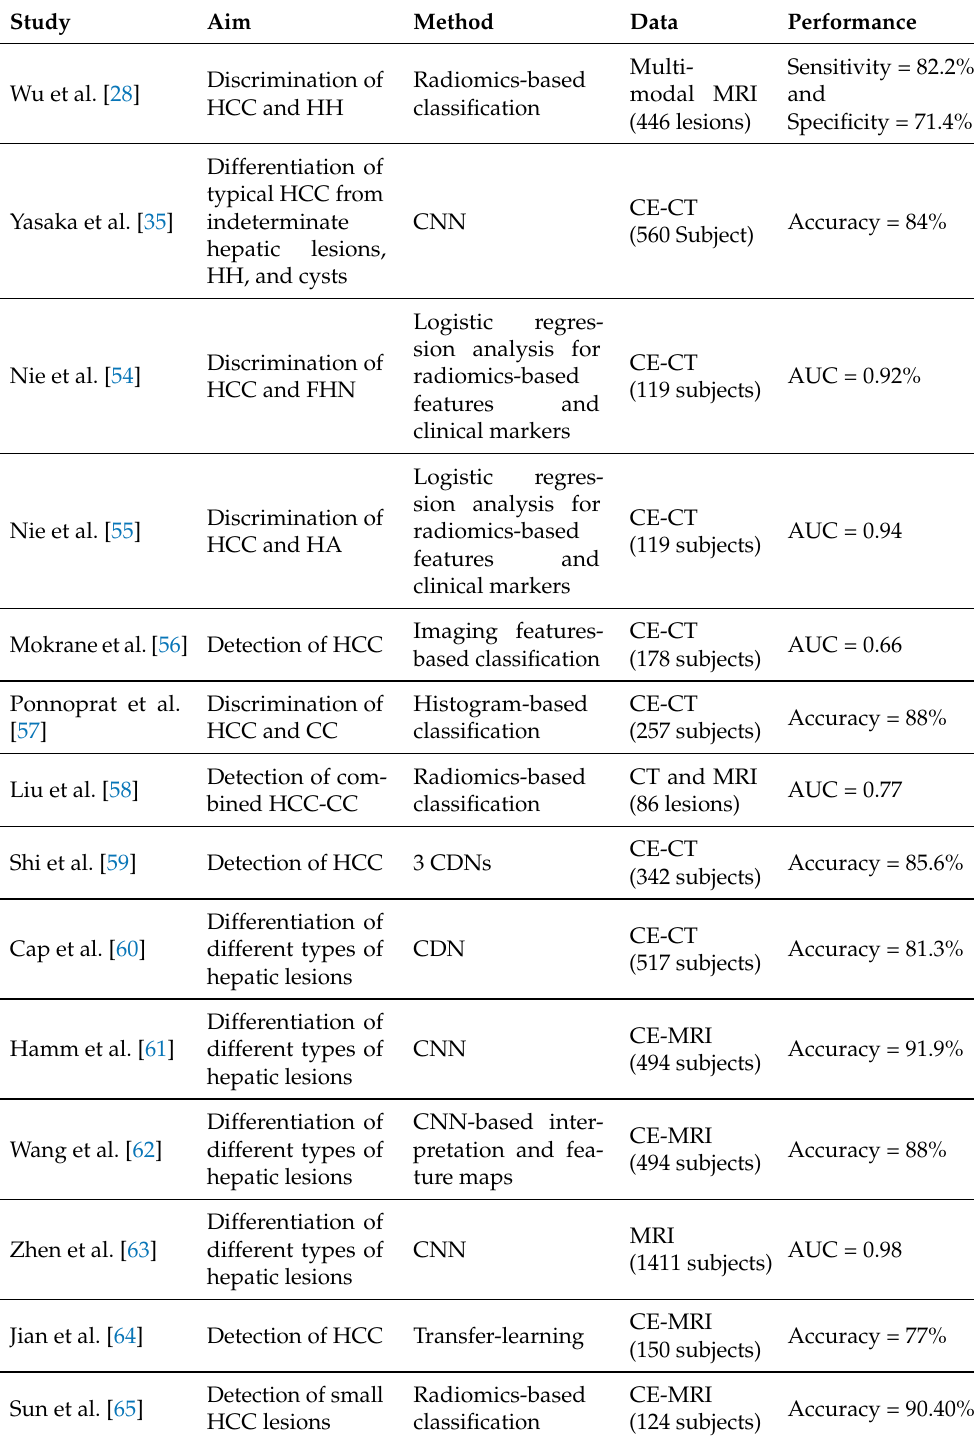
Table 2. Detection and differentiation of HCC from other hepatic